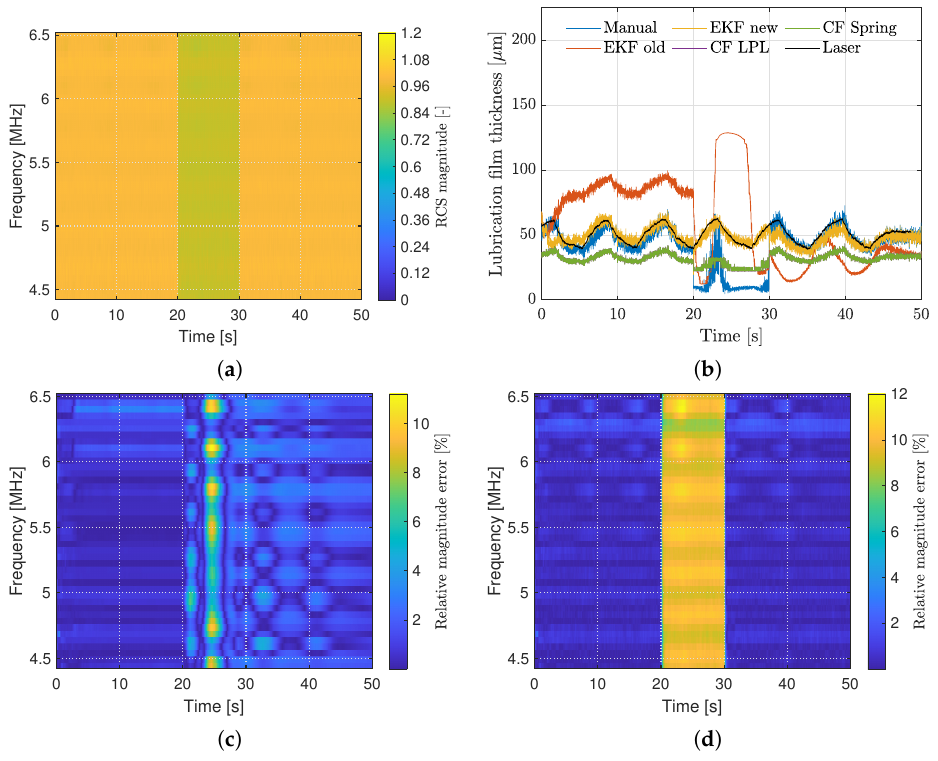
Figure 14. Robustness and reliability analysis of the extended Kalman filter structure. ( a ) Spectrogram of the reflection coefficient spectrum. ( b ) Average lubrication film thickness. ( c ) Magnitude error from the original extended Kalman filter structure. ( d ) Magnitude error from the new extended Kalman filter